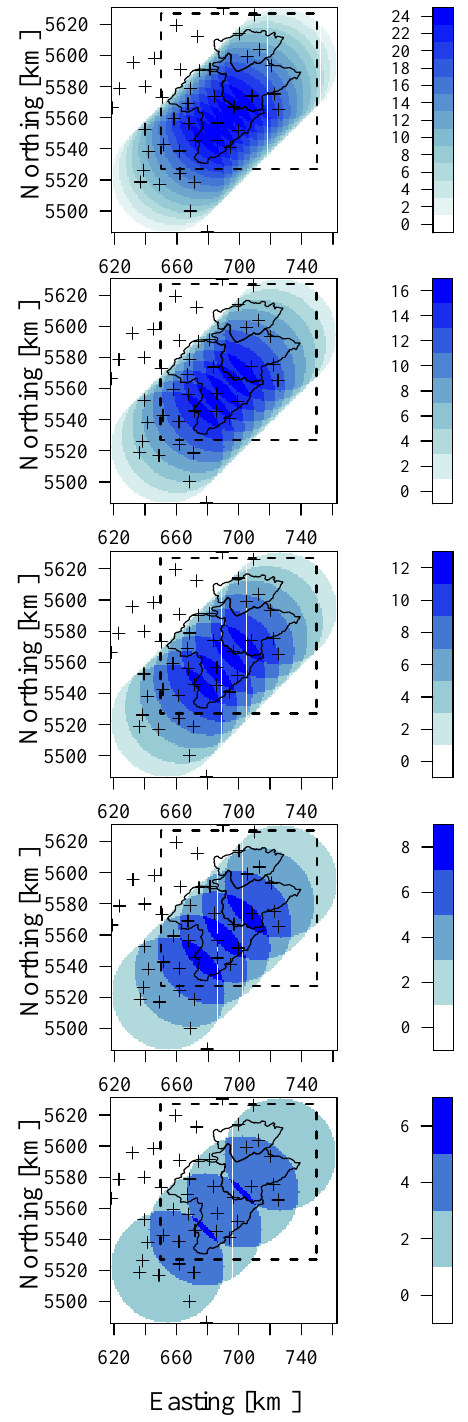
Fig. 5. Sensitivity analysis. Five synthetic rainfall events of circular shape with an intensity of 2mmh − 1 and advection speeds of 6, 8, 11, 17, 25kmh − 1 and durations of 18, 12, 9, 6 and 4h, respec- tively (from top panel to bottom panel) over a 145km × 145km grid with 1km × 1km resolution. The figures show precipitation sums. The plusses are rain gauges and the dashed box delineates the 100km × 100km simulation